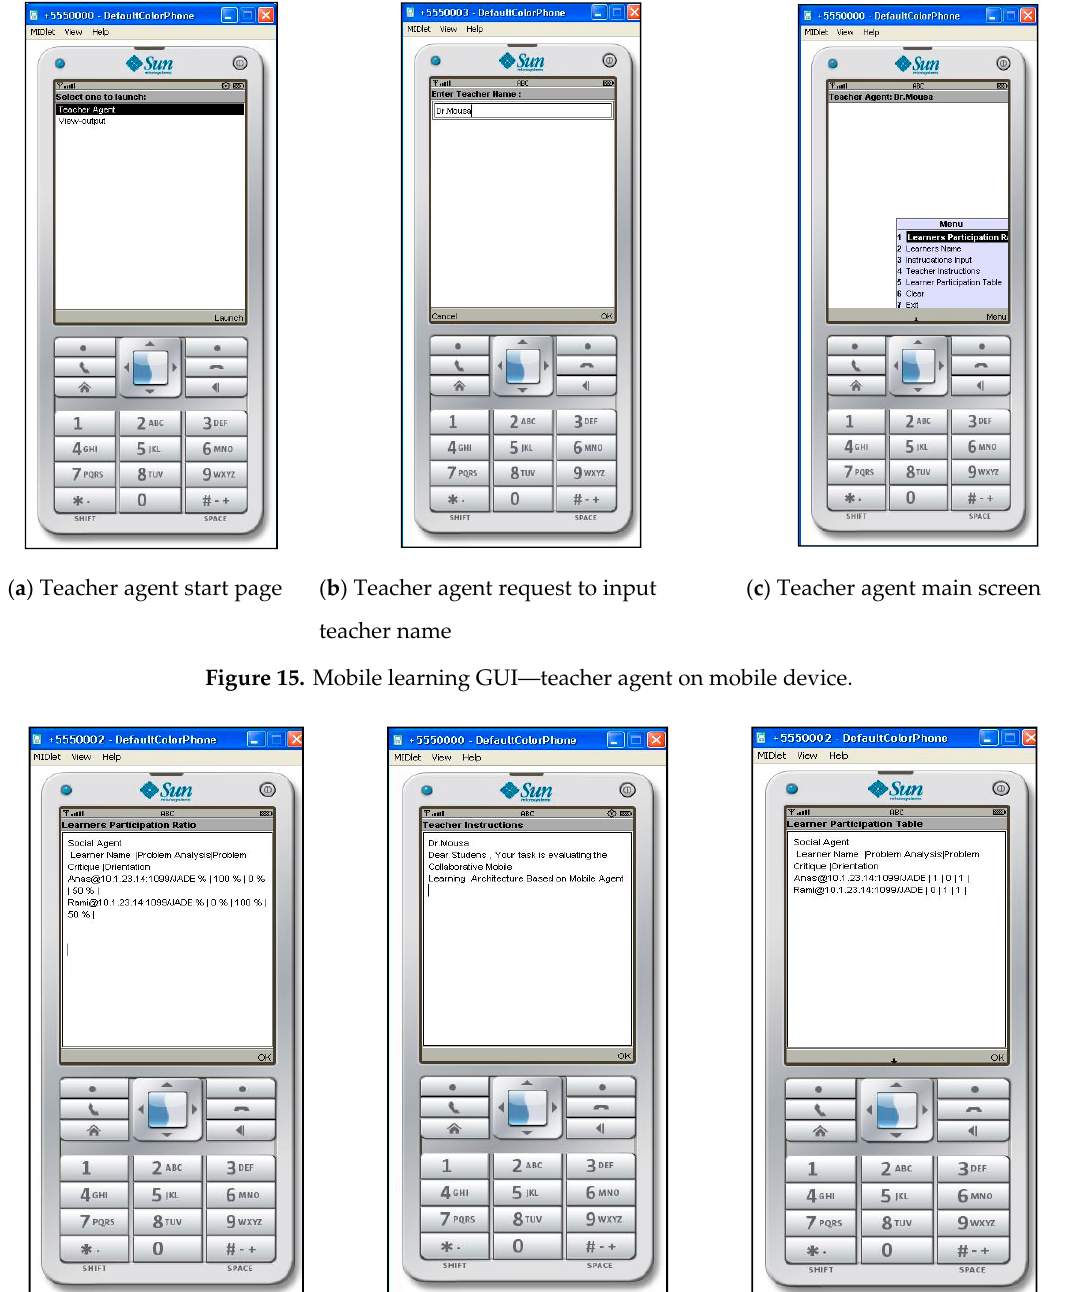
Figure 17. GUI of the social agent. The social agent items are described as follows: 1.